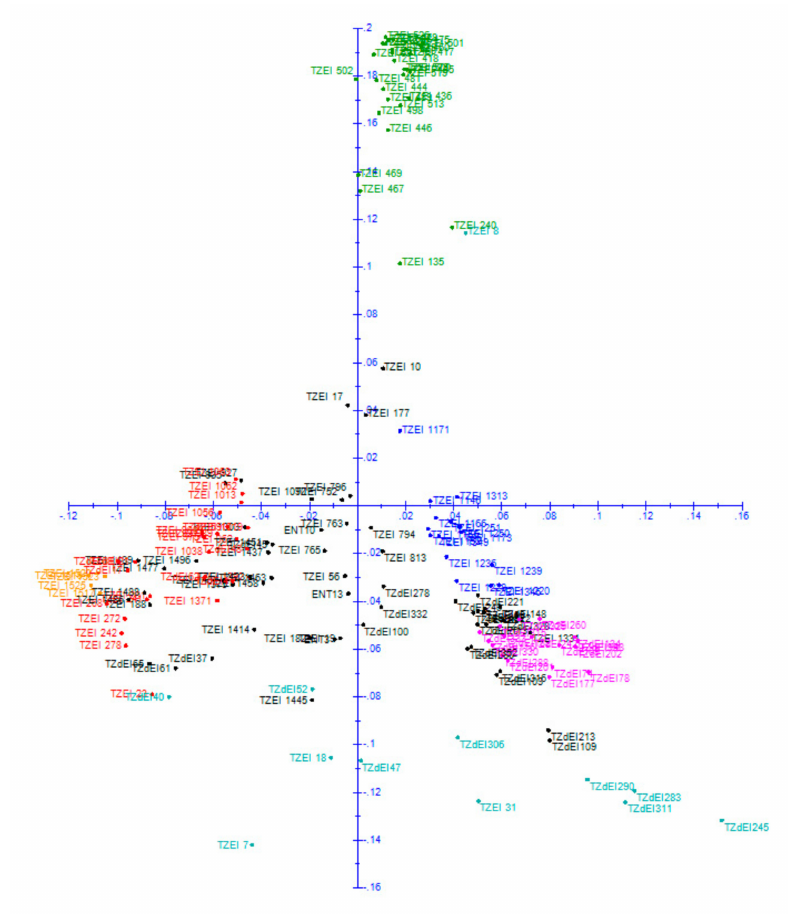
Figure 6. Principal coordinate analysis (PCoA) of 162 early yellow and white inbred lines genotyped using 9864 DArT